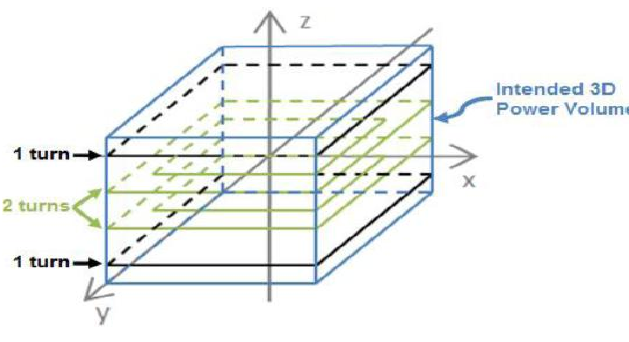
Figure 2: Vertical field conceptual box.